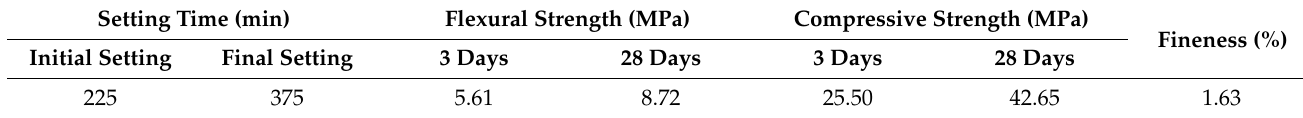
Table 3. Main performance indices of cement.